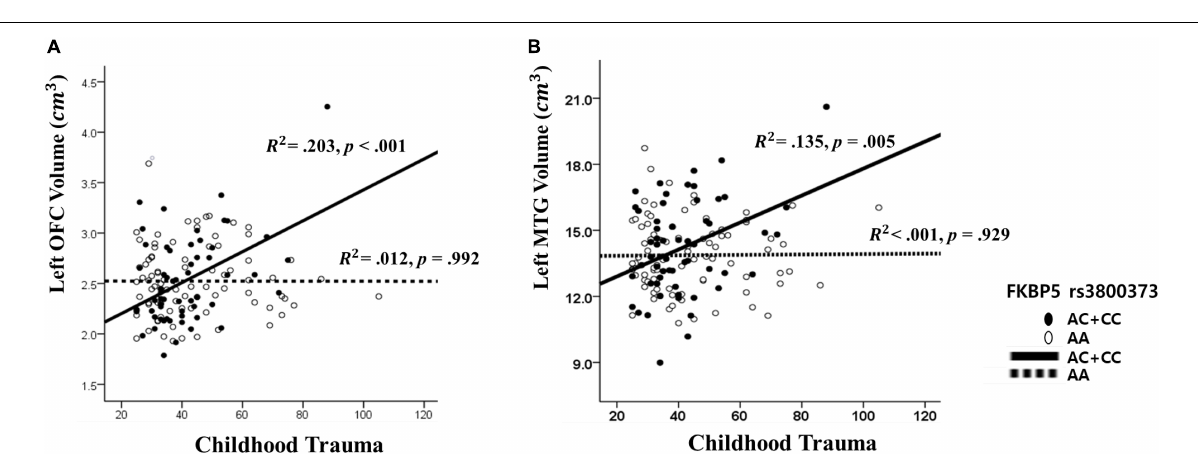
FIGURE 2 | The interaction effect of FKBP5 rs3800373 and childhood trauma on (A) the left orbitofrontal cortex and (B) the left Middle Temporal Gyrus. (A) The other interaction effects had similar patterns in rs1360780, rs4713916, rs4713919, rs6902321, and rs3798345. (B) The other interaction effects had similar patterns in rs1360780, rs4713916, and